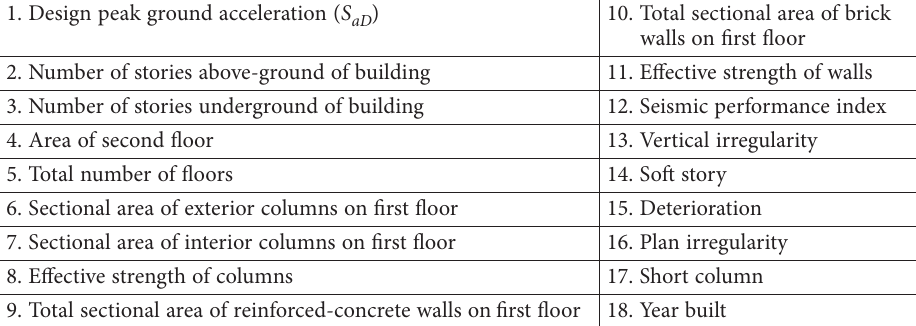
Table 3. Building-characteristic input factors (in descending order by seismic